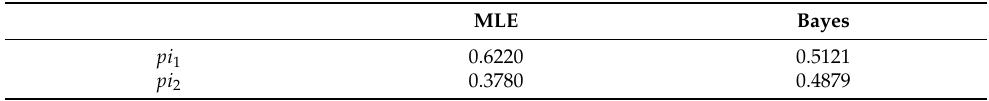
Table 12. Estimated relative risks for two